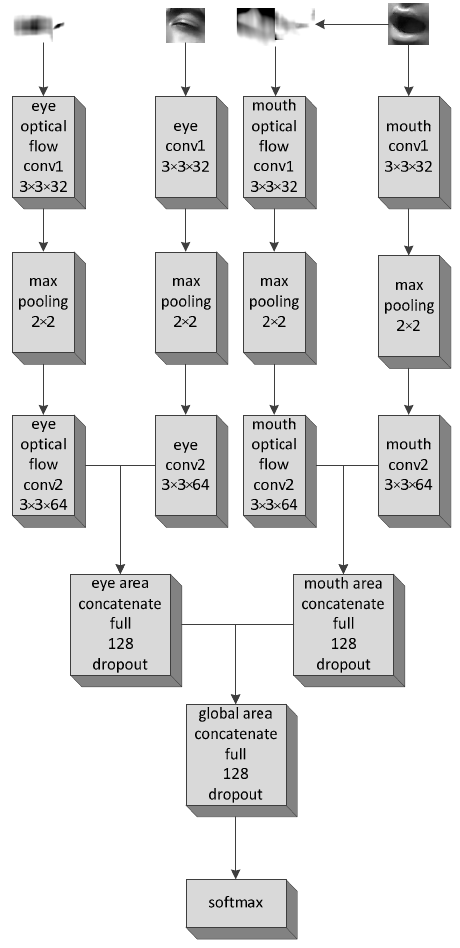
Figure 8. Fatigue detection network.